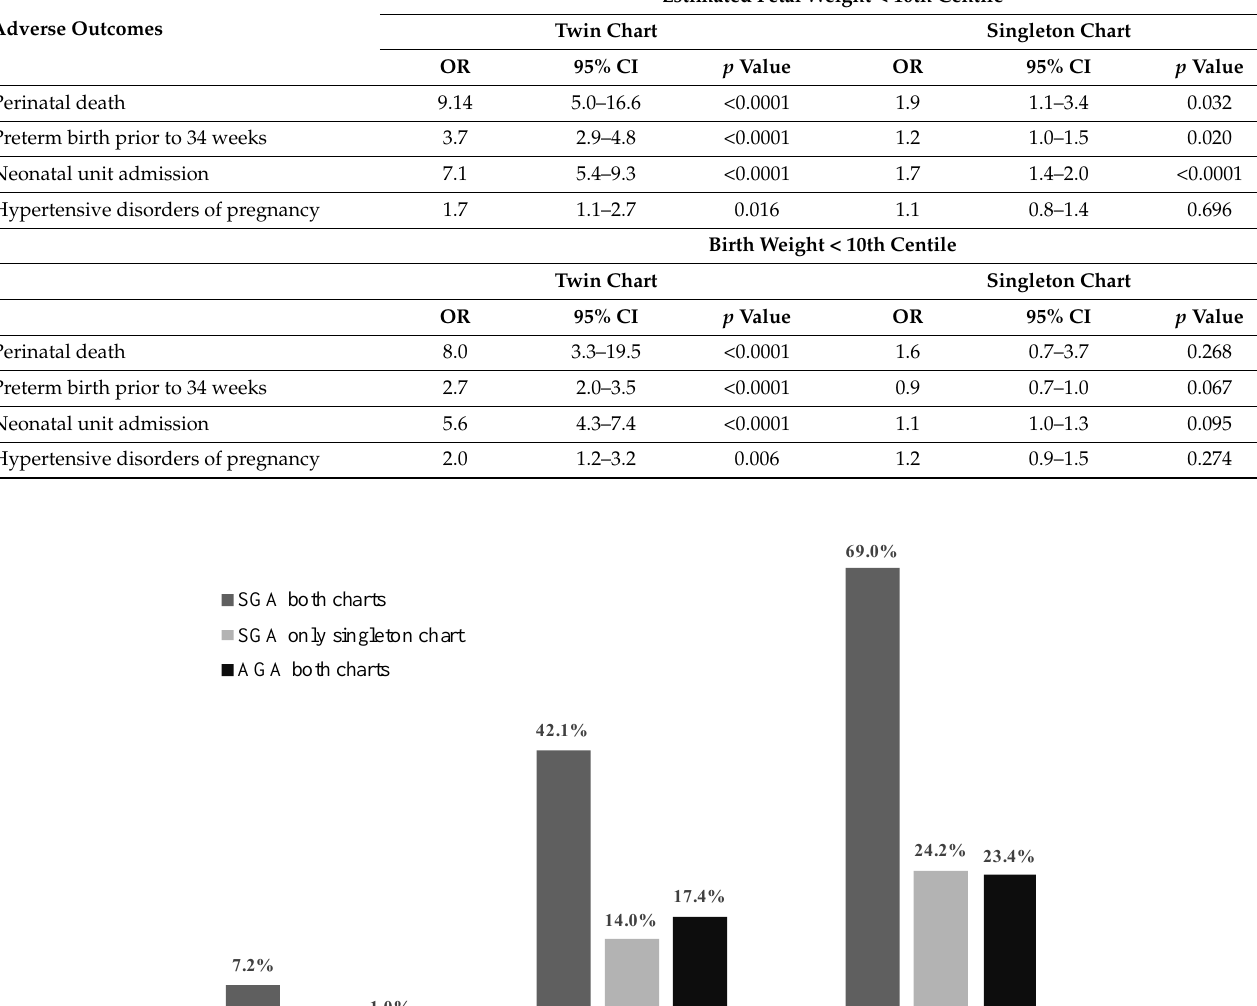
Figure 1. Adverse perinatal outcomes in small for gestational age (SGA) fetuses according to singleton and twin charts, SGA identified only by singleton chart and non-SGA (AGA) fetuses according to singleton and twin charts using estimated fetal